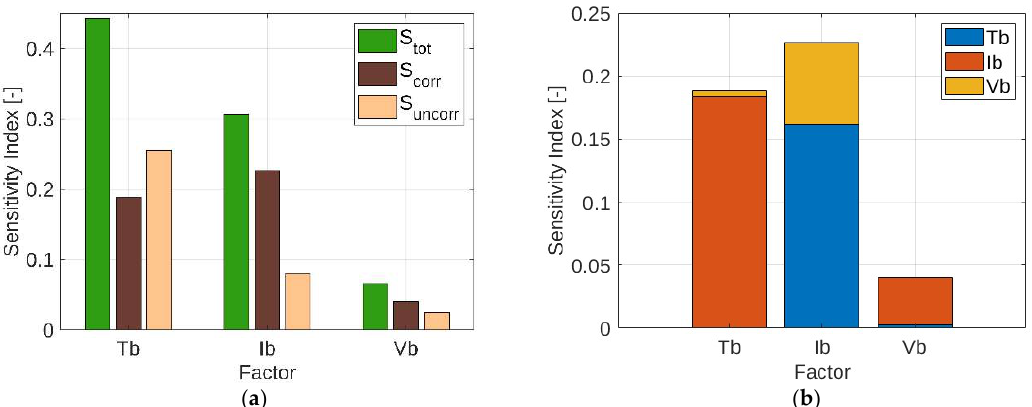
Figure 20. Sensitivity indices of the crucial operation factors affecting the variation in the IRB. ( a ) The partial variance decomposition is on the left, and ( b ) the normalized second-order effects are on the right.